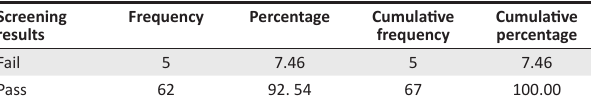
TABLE 2: Results from the dysphagia screening ( n = 67).